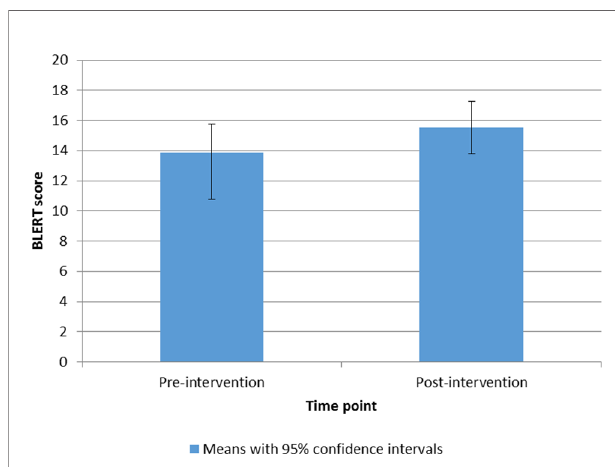
FIGURE 3 | Bar chart to show means and 95% con fi dence intervals of BLERT scores from pre- to post-intervention.